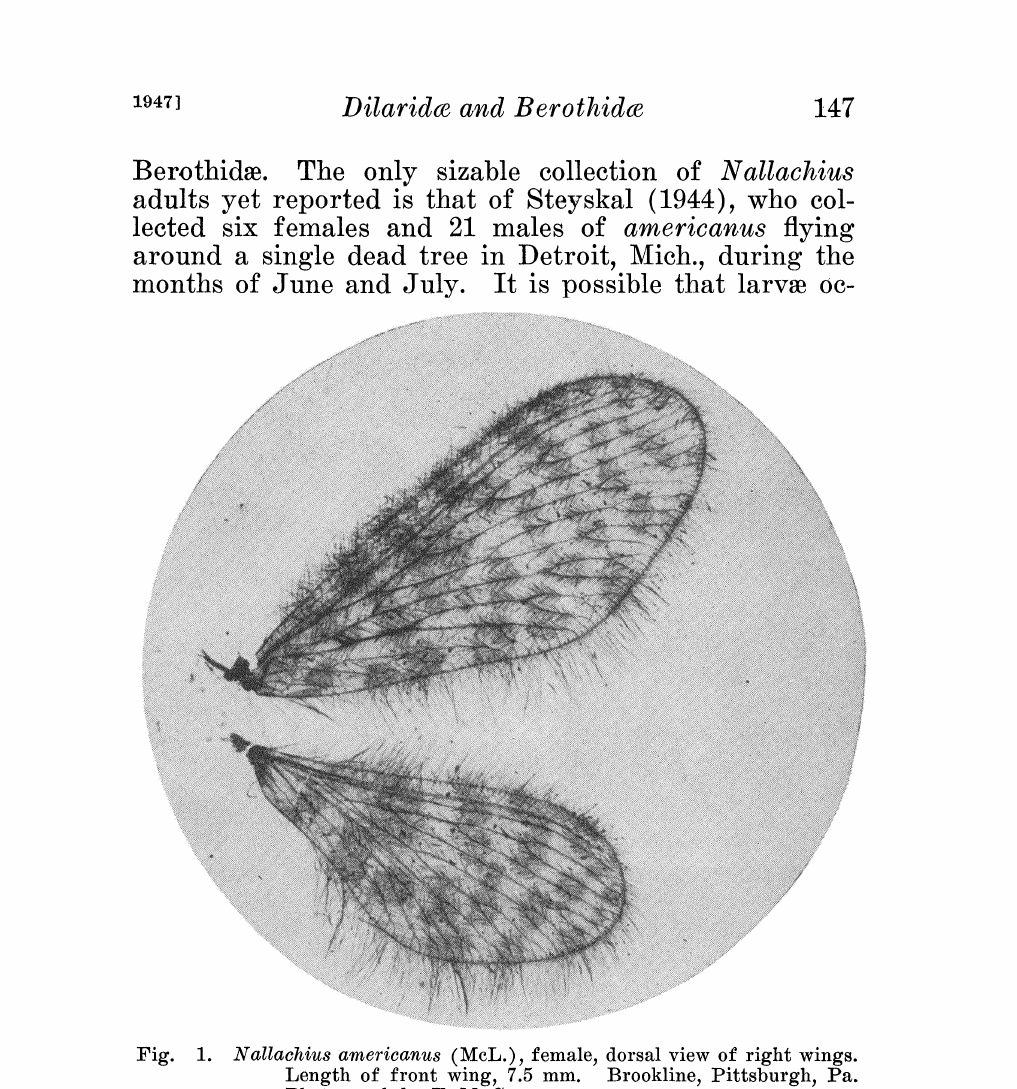
Fig. 1. Nallachius americanus (McL.), female, dorsal view of right wings. Length of front wing, 7.5 mm. Brookline, Pittsburgh, Pa. Photograph by F. M.